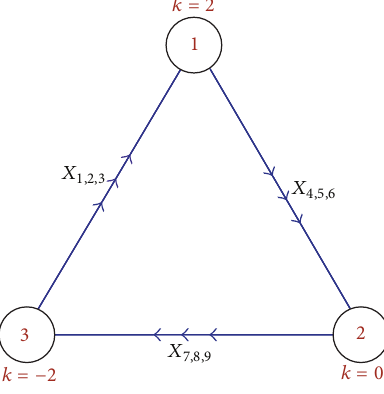
Figure 8: Quiver diagram for Fano B 1